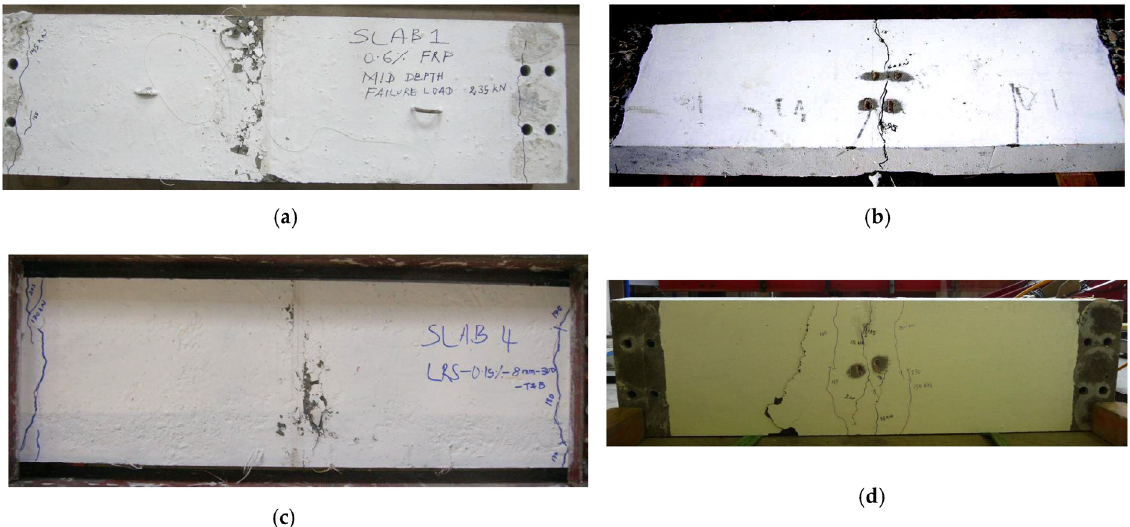
Figure 5. Crack patterns in slabs. ( a ) Typical crack pattern on the top surface of the unreinforced and 0.6% single mid-depth-reinforced slabs. ( b ) Typical crack pattern on the soffit of the unreinforced and 0.6% single mid-depth-reinforced slabs. ( c ) Typical crack pattern on the top surface of the two-layer-reinforced test slabs and 0.15% single mid-depth-reinforced slabs. ( d ) Typical crack pattern on the soffit of the two-layer-reinforced test slabs and 0.15% single mid-depth-reinforced slabs.